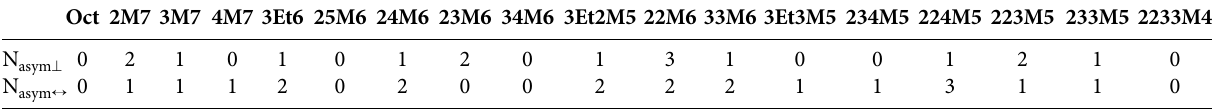
Table 1. Asymmetry Numbers of octane isomers.